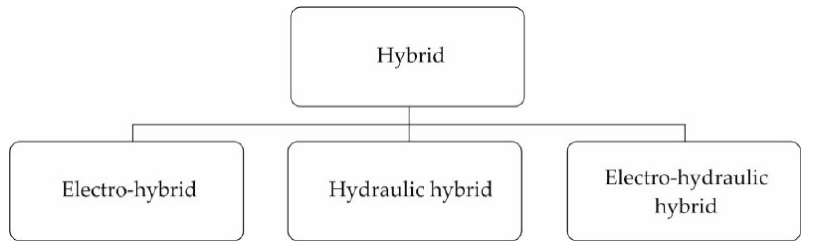
Figure 1. Hybrid drive classification.